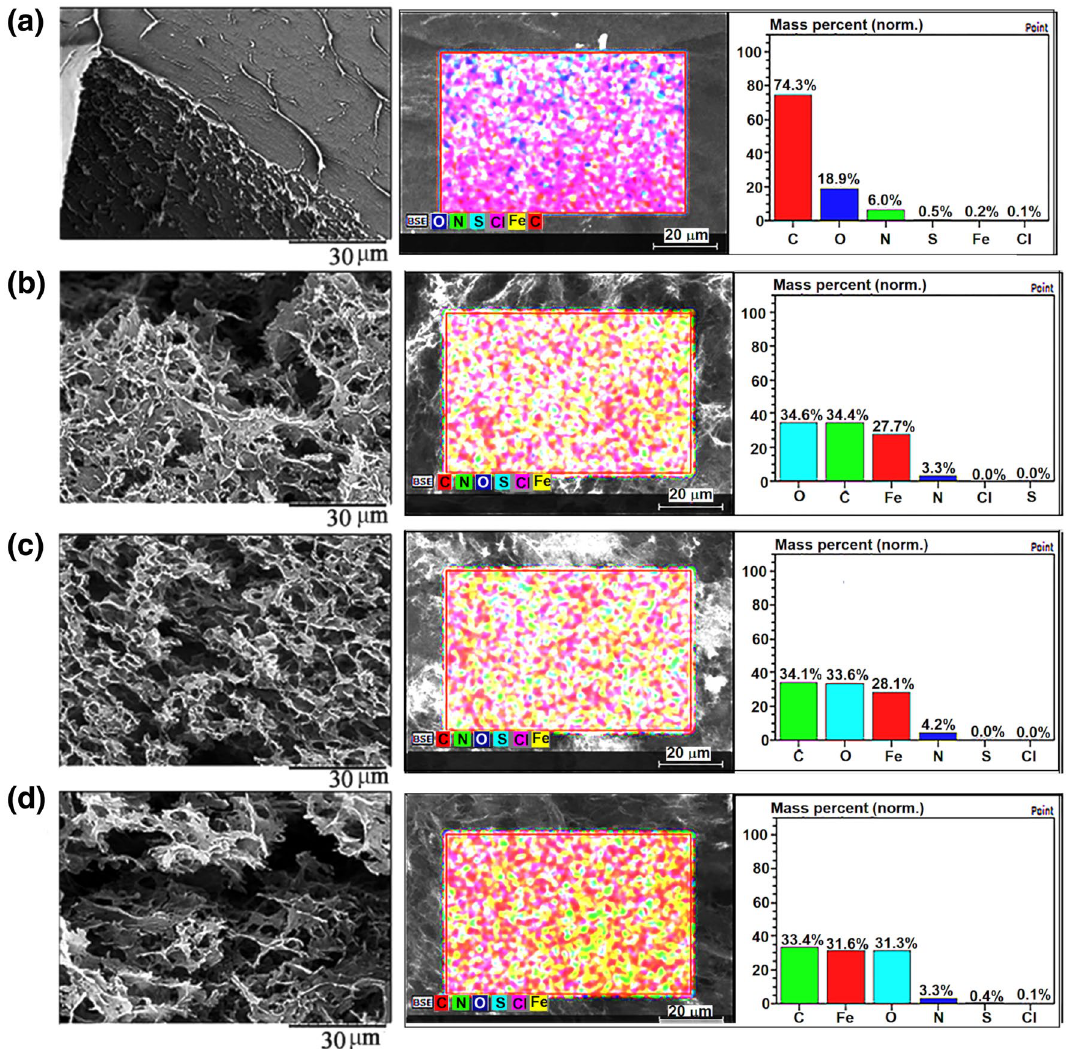
Figure 3. Surface morphology, mapping and elemental composition of the 3D nanocomposites ( a ) Neat 3D-rGO; ( b ) Th-rGO/Fe 3 O 4 /PVP; ( c ) Ch-rGO/Fe 3 O 4 ; and ( d ) Th-rGO/Fe 3 O 4